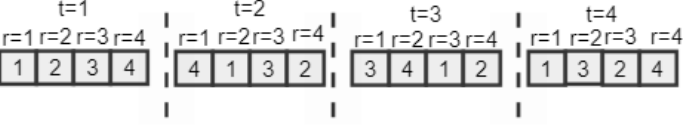
Fig. 4. An example of solution representation